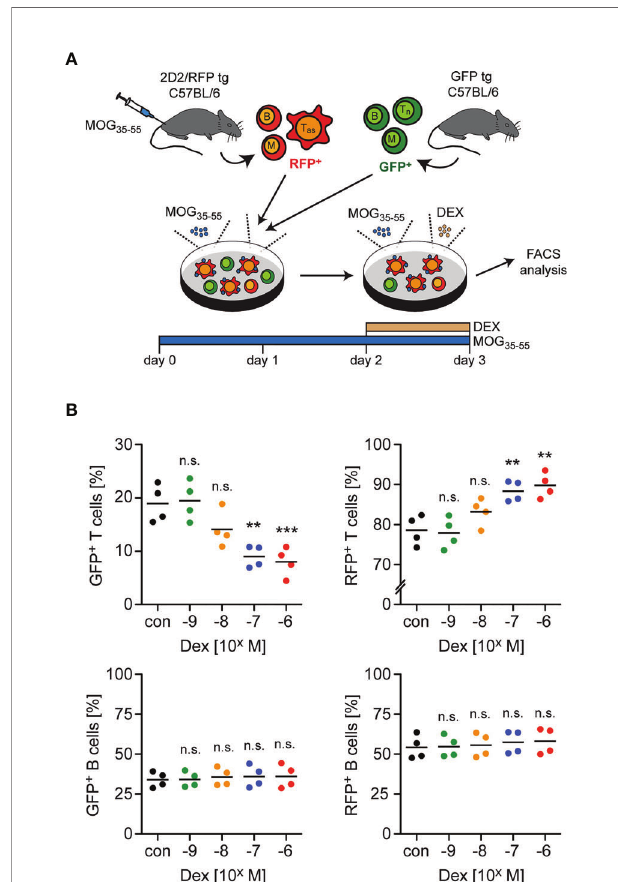
FIGURE 1 | Enrichment of antigen-primed effector T cells after GC treatment in vitro . (A) Setup of the experimental model. (B) Percentages of live/dead – (naïve) GFP + T cells (upper left panel) as well as live/dead – (antigen-primed) RFP + T cells (upper right panel) after 3 days of cell culture in the presence of the indicated concentrations of Dex for the last 24 hrs. In control (con) conditions, no Dex was added to the cell culture. Percentages of GFP + B cells (lower left panel) and RFP + B cells (lower right panel) were determined in the same cultures. Each dot corresponds to cells originating from one individual mouse, the horizontal line represents the mean. N=4 (biological replicates from individual mice). Statistical analysis was performed by One- way ANOVA followed by a Newman-Keuls Multiple Comparison test. Levels of signi fi cance (depicted for the comparison between control and Dex-treated cultures): n.s. = not signi fi cant; **p < 0.01; ***p < 0.001. T as , antigen-speci fi c T cells; T n , naïve T cells; B, B cells; M, myeloid